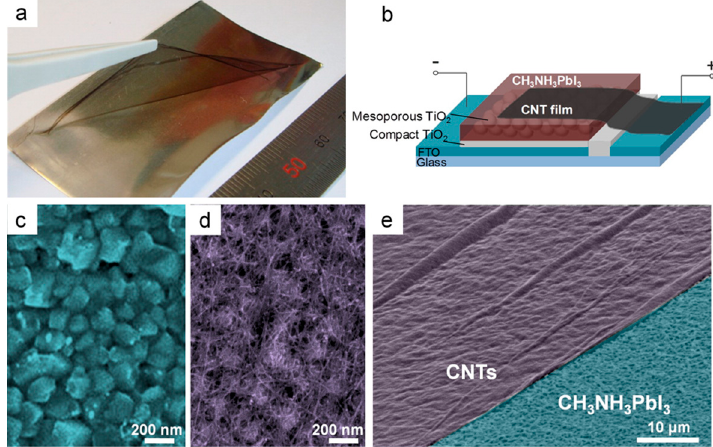
Figure 23. ( a ) Photo of freestanding CNT film lifted by tweezers; ( b ) mesoscopic CH 3 NH 3 PbI 3 perovskite solar cell with CNT film electrode; ( c ) top view SEM images of CH 3 NH 3 PbI 3 perovskite substrate before and ( d ) after CNT transfer; ( e ) tilted SEM image of CH 3 NH 3 PbI 3 perovskite substrate (blue) partly covered by CNT film (purple) (reproduced with permission from [151], published by the American Chemical Society).